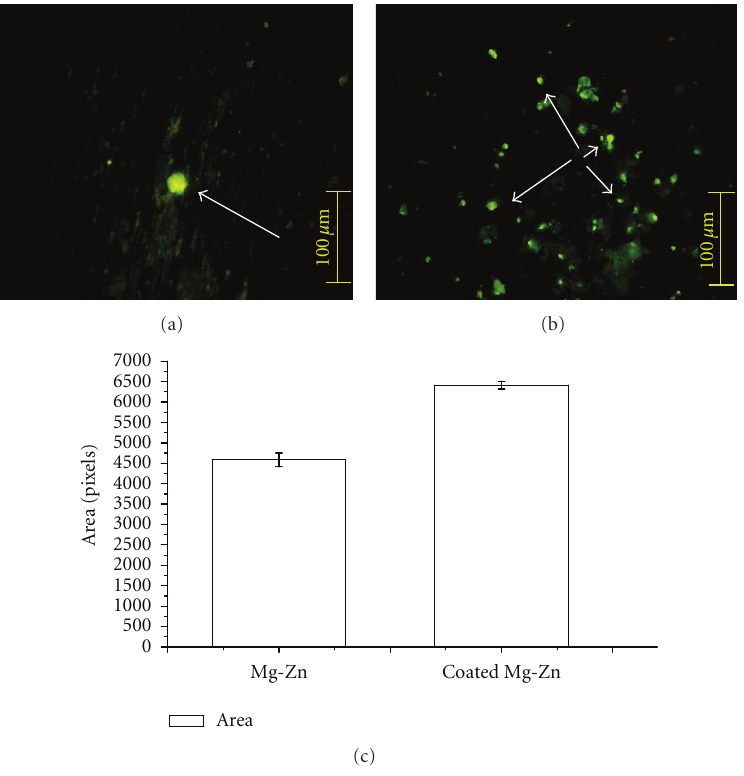
Figure 1: Typical calcification and calcium deposition (white arrows) fluorescence photographs after 14 days’ culture in osteogenic medium and labeled in tetracycline. (a) The result on the Mg-Zn alloy. Scale bar = 100 μ m. (b) The result on the coated one. Scale bar = 100 μ m. (c) The calculated size of mineralization area of hBMSCs after 14 days of culture (mean ± SD, P < 0 .